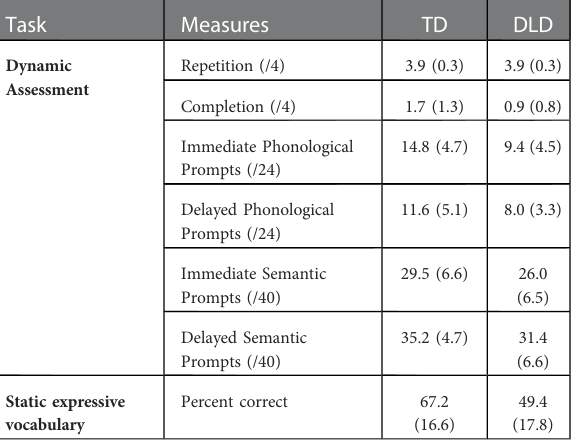
TABLE 6 Means (SDs) on each measure according to developmental group. Task